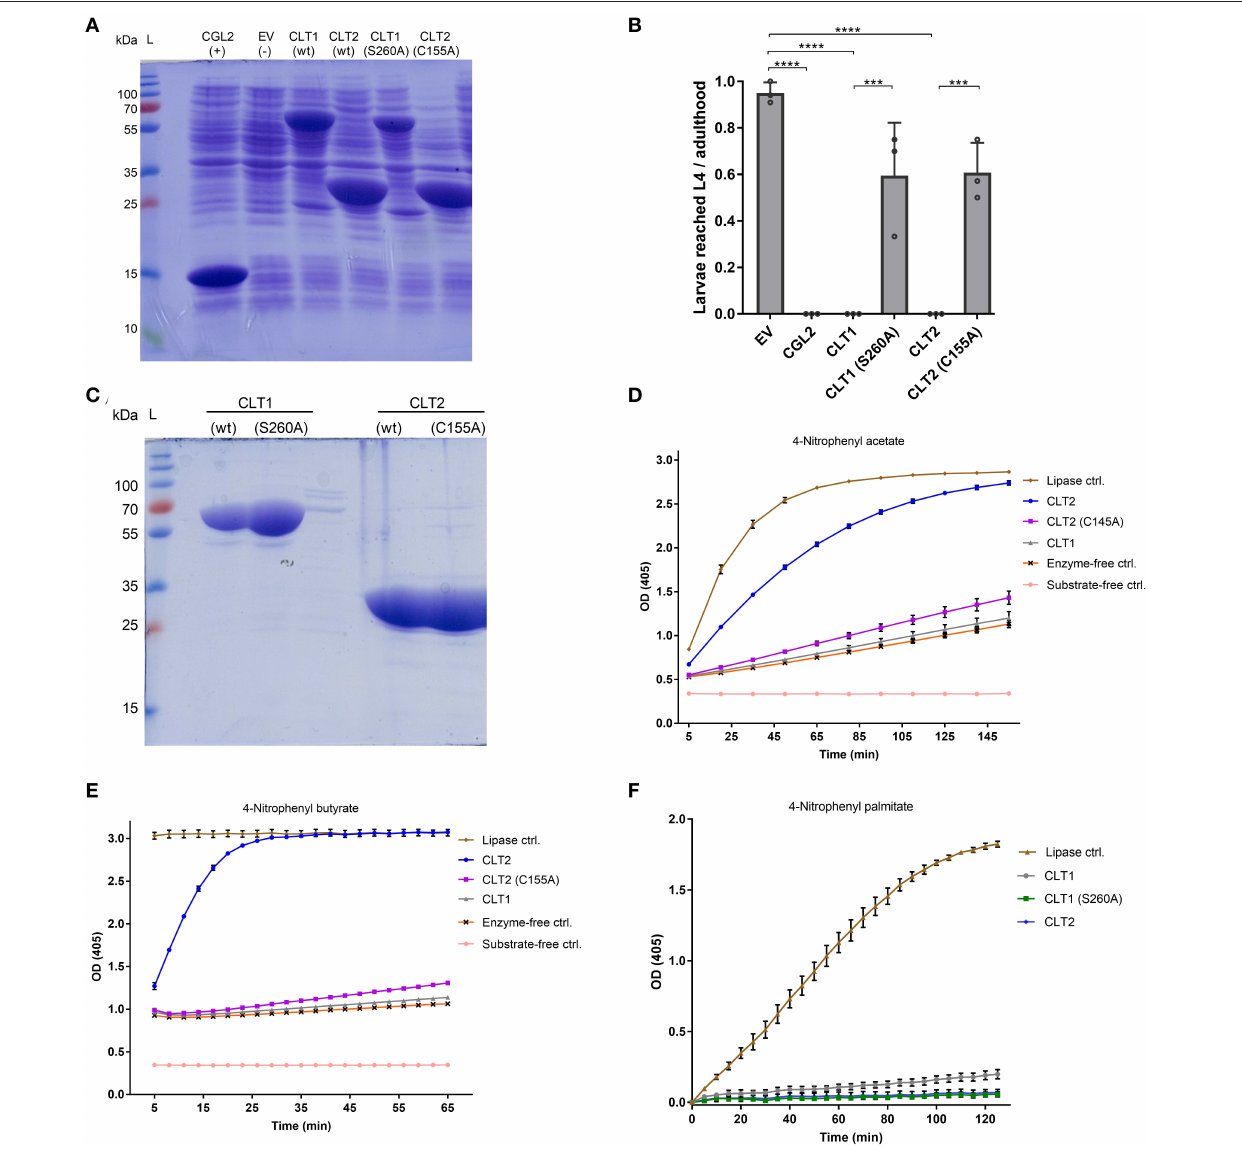
FIGURE 4 | In vitro lipase activity of wild type CLT1 and CLT2 proteins and their putative catalytic site mutants. (A) Heterologous expression of N-terminally Hi8-tagged, wild type CLT1 and CLT2 proteins and their putative catalytic site mutants. Twenty microliter of bacterial lysate was loaded on a SDS-PAGE and stained with Coomassie blue. CGL2 and “empty” vector (EV) was used as positive and background controls for IPTG-induced expression, respectively. (B) Effect of catalytic site mutations on the toxicity of CLT1 and CLT2 against C. elegans N2. IPTG-induced E. coli BL21 expressing previously characterized nematotoxic protein CGL2 and containing “empty” vector (EV) were used as positive and negative controls, respectively. Dunnett’s multiple comparisons test was used for statistical analysis. Error bars represent the standard deviation of three biological replicates. **** p < 0.0001 vs. EV. (C) The recombinant proteins were purified over Ni-NTA beads and 10 µ l of the final eluate were run out on a SDS-PAGE followed by Coomassie staining. The masses of the molecular marker proteins are indicated. Lipase activity of the purified proteins was assessed toward p -nitrophenyl acetate (D) , p -nitrophenyl butyrate (E) , and p -nitrophenyl palmitate (F) . Enzyme activity is shown as mean values ± SD ( n = 4) for each time point. The error bars indicate standard deviation of four technical replicates. The error bars were not drawn if they are shorter than the height of the symbol. Candida rugosa lipase (L1754, Sigma) was used as a positive control and labeled as “Lipase